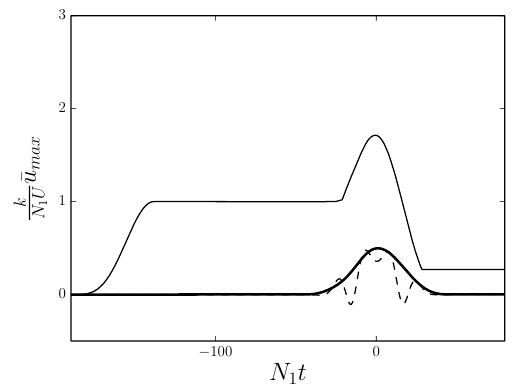
Figure 15. Time history of the maximum of the mean flow. The dashed line is the velocity jump at the interface while the thick solid line that is the maximum the interference mean u i . The parameter √ values are n 1 /k = 1 / 2, N 2 /N 1 = 2, (cid:15) = 0.025, and α = 0.1.